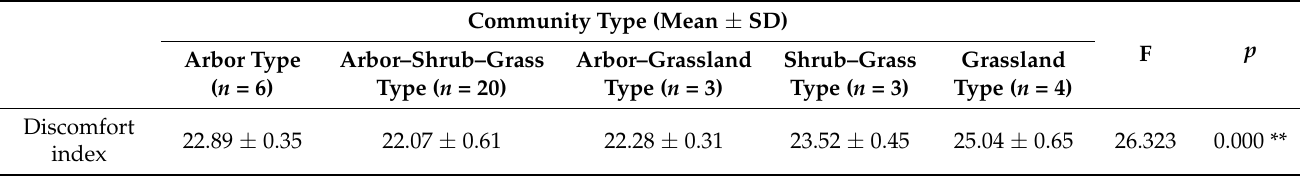
Table 4. Discomfort and the results for the variance analysis of plant community structures.